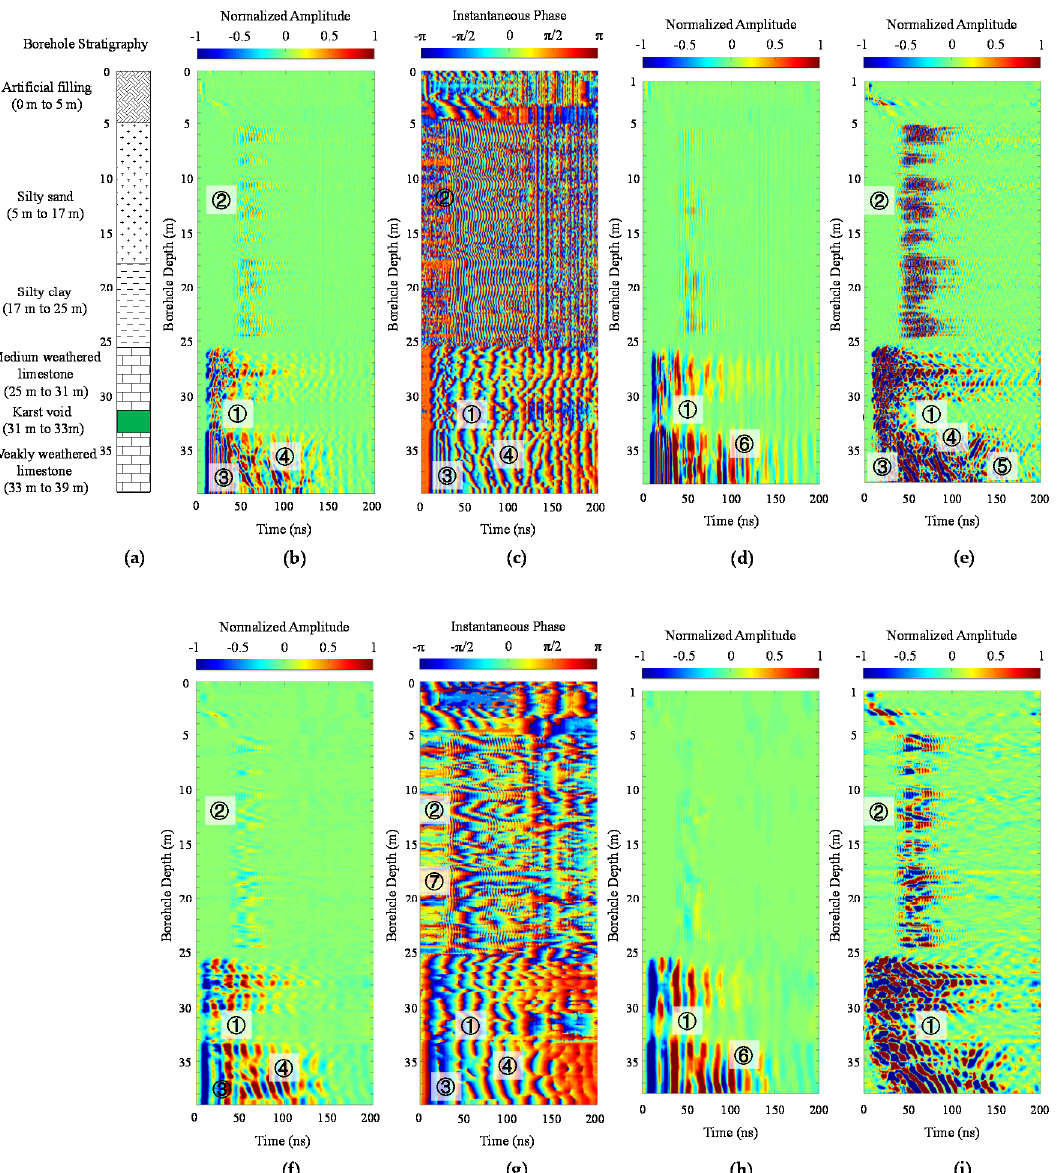
Figure 7. Single borehole GPR detection data on a typical karst void borehole scenario. ( a ) No. ZK-2-23 borehole stratigraphy; ( b ) original radar data; ( c ) instantaneous phase; ( d ) removed wave profile using median filtering; ( e ) median filtered wave; ( f ) Low-pass filtered radar data; ( g ) instantaneous phase of low-pass filtered radar data; ( h ) median filtering removed wave profile of low-pass filtered data; ( i ) median filtered wave of low-pass filtered data.